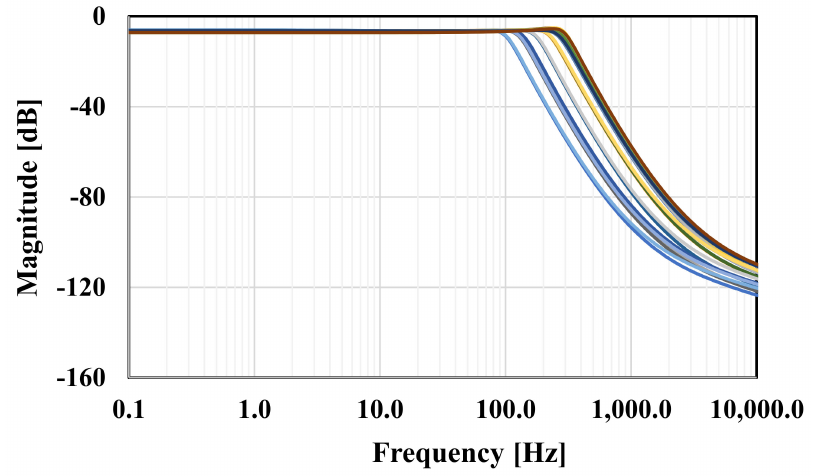
Figure 14. The frequency response of the proposed filter under process, voltage and temperature (PVT)